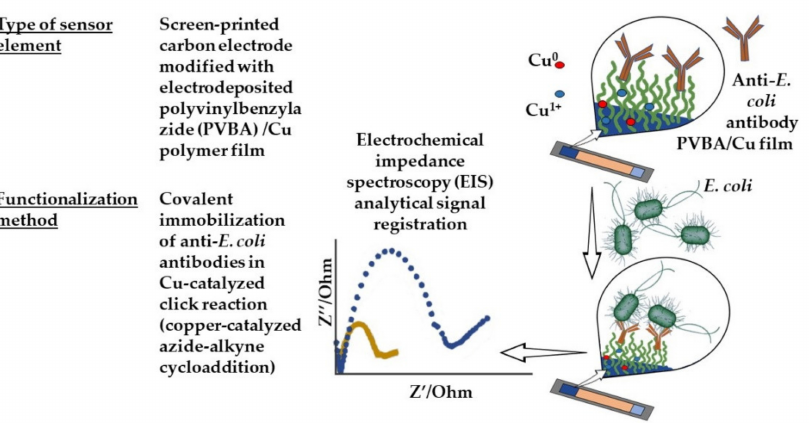
Figure 5. A label-free impedimetric immunosensor based on covalent antibody immobilization.